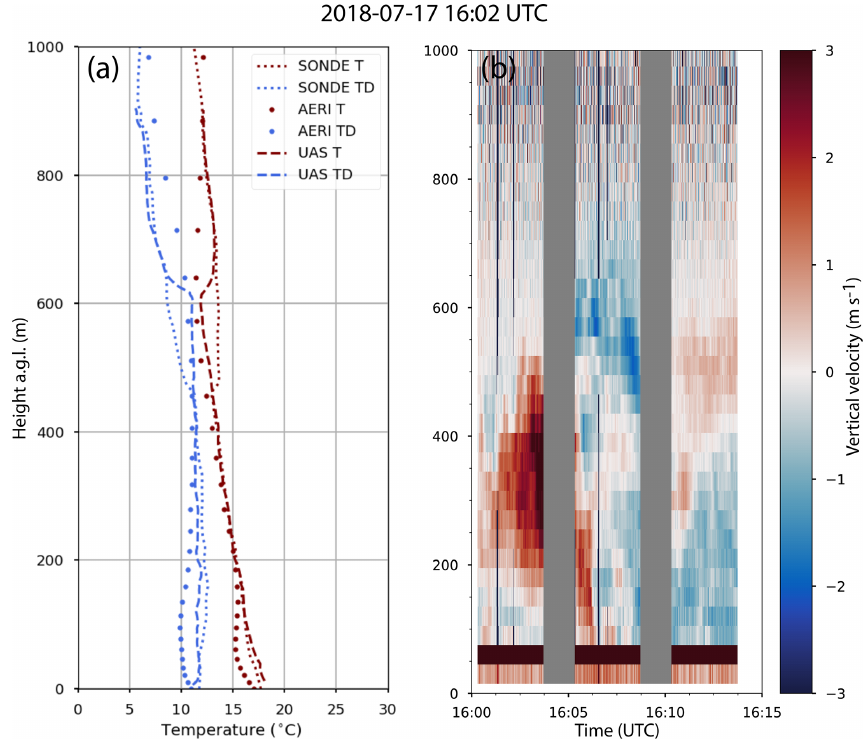
Figure 3. Example profile of temperature (red) and dew point temperature (blue) from each observation platform (a) and a time height cross section of vertical velocity measured from the CLAMPS DL from the same time period (b) . The grey areas in (b) indicate the DL was not in vertical stare mode and was performing PPI